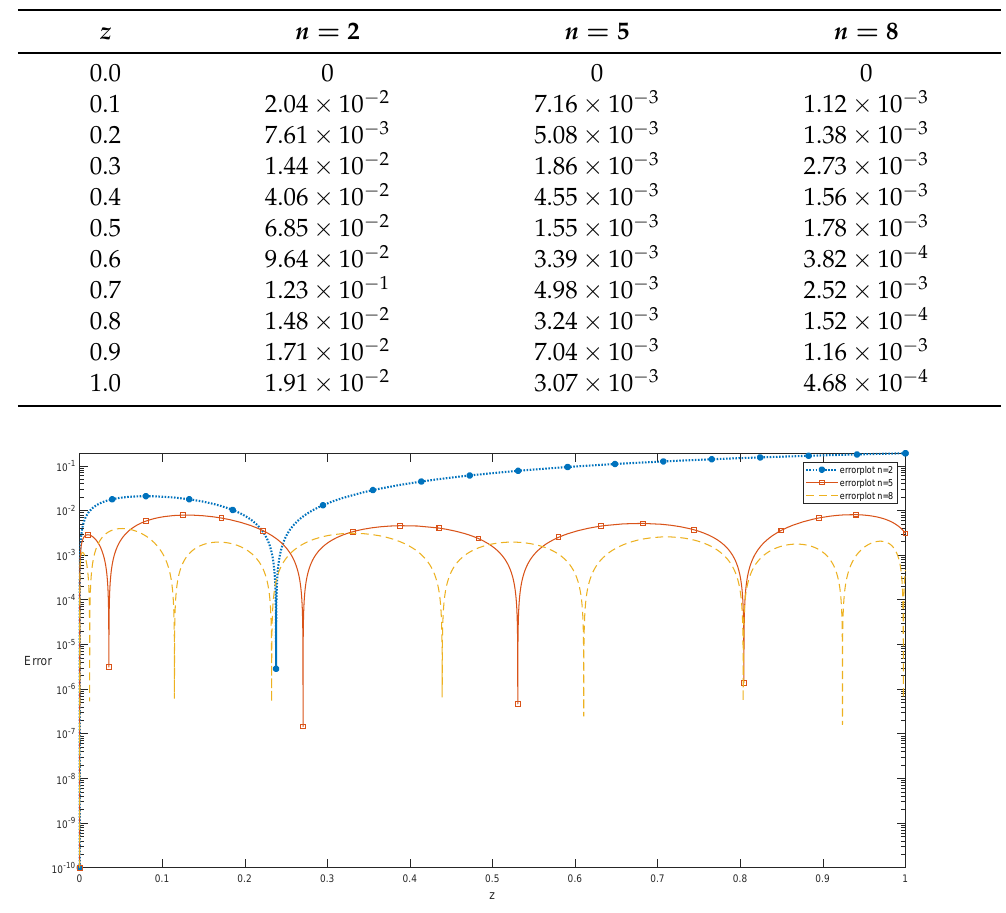
Figure 2. Error plots of Example 2 at different scale levels.